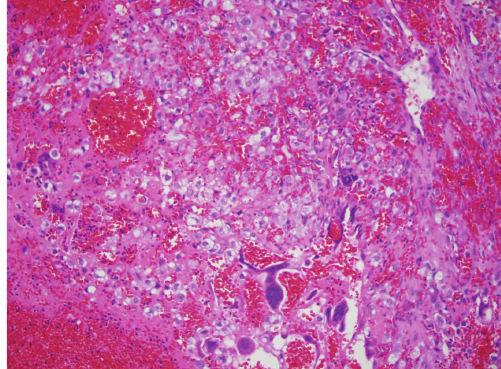
Figure2:Ovariancystwithhemorrhage,decidua,andtrophoblastic tissue